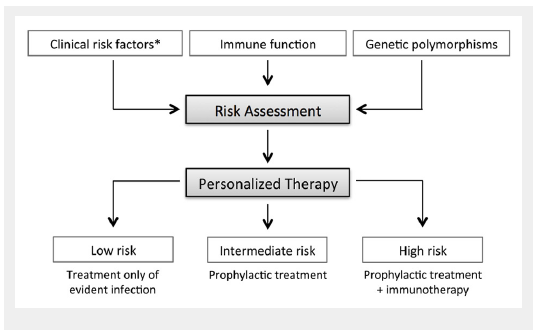
Possible risk assessment and personalised therapy scheme for patients at risk for invasive fungal infections. *Clinical risk factors include graft-versus-host disease, steroid treatment, T cell-depleted graft and acute myeloid leukemia.